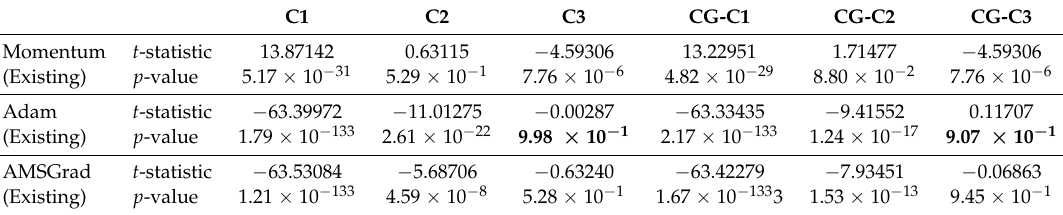
Table 4. Results of t -test on the training error rates of the existing algorithms (Momentum, Adam, and AMSGrad) and Algorithm 1 (C i and CG-C i ( i = 1,2,3)) on the IMDb dataset (significance level is 5%; the p -values for the proposed algorithms with significantly low error rates are indicated in